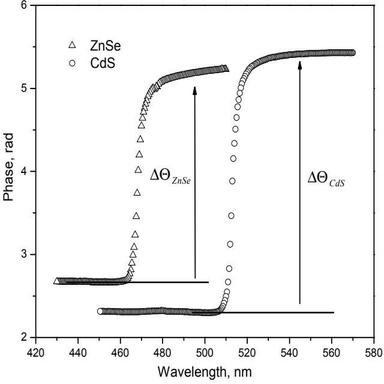
The PPES phase characteristics of ZnSe (triangles) and CdS (circles) crystals as a function of the wavelength measured at the modulation frequency of 10 Hz. The arrows denote the phase difference for both samples.